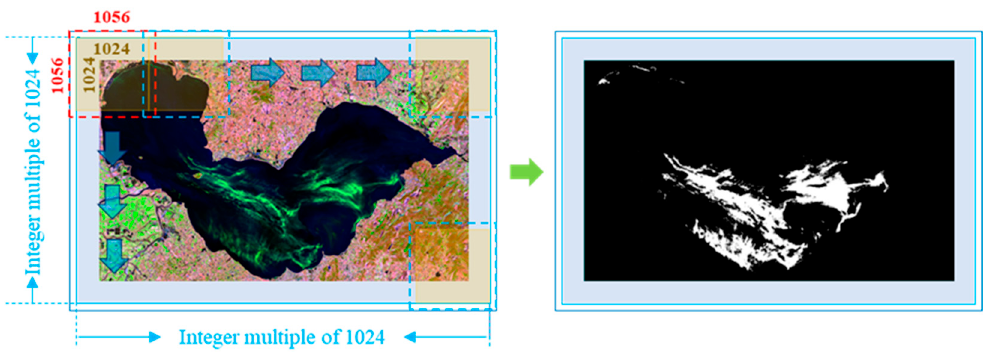
Figure 6. “Sliding window prediction” of CyanoHABs using a model. The red dashed box indicates the starting position of clipping, and the blue dashed boxes indicate the position to which the sliding window slides. The blue arrows indicate the sliding direction.